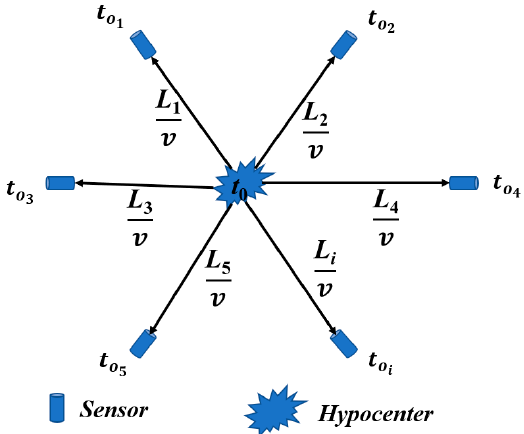
Figure 4. Schematic of locating the source based on the arrival time difference approach.